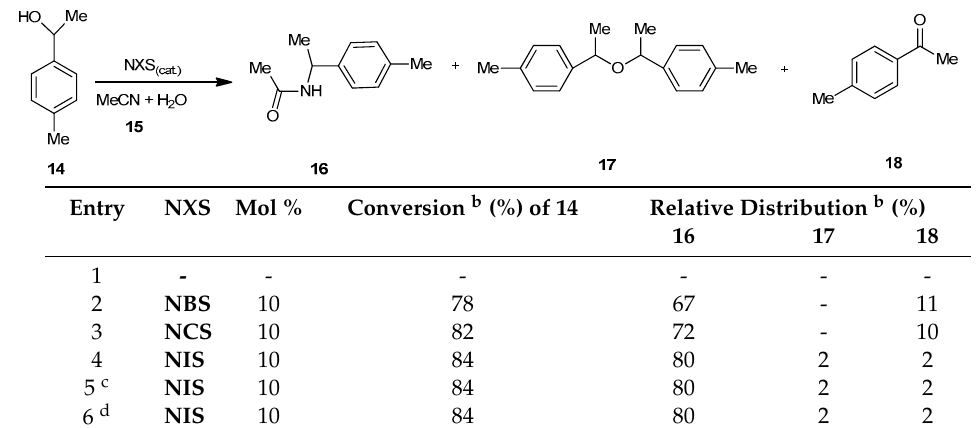
Table 3. The effect of NXS as the mediator on conversion of 1-( p -tolyl)ethan-1-ol 14 in acetonitrile solution a .